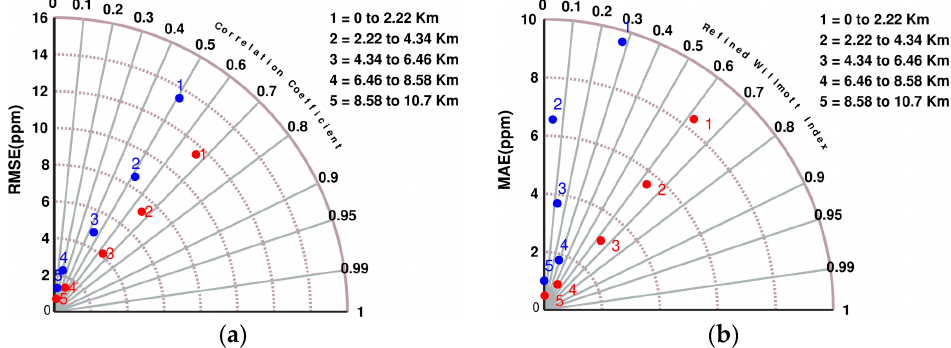
Figure 9. ( a ) The comparison of the RMSE and correlation coefficient value for the ELM and GPT3w at different altitudes; ( b ) The comparison of the MAE and RWI value for the ELM and GPT3w at different altitudes. The red and blue points correspond to ELM and GPT3w statistic parameters, respectively.